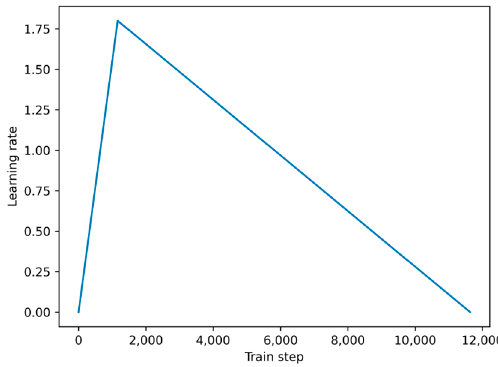
10 of 21 Figure 3. Network architecture, classi fi cation model based on transfer learning using BERT.